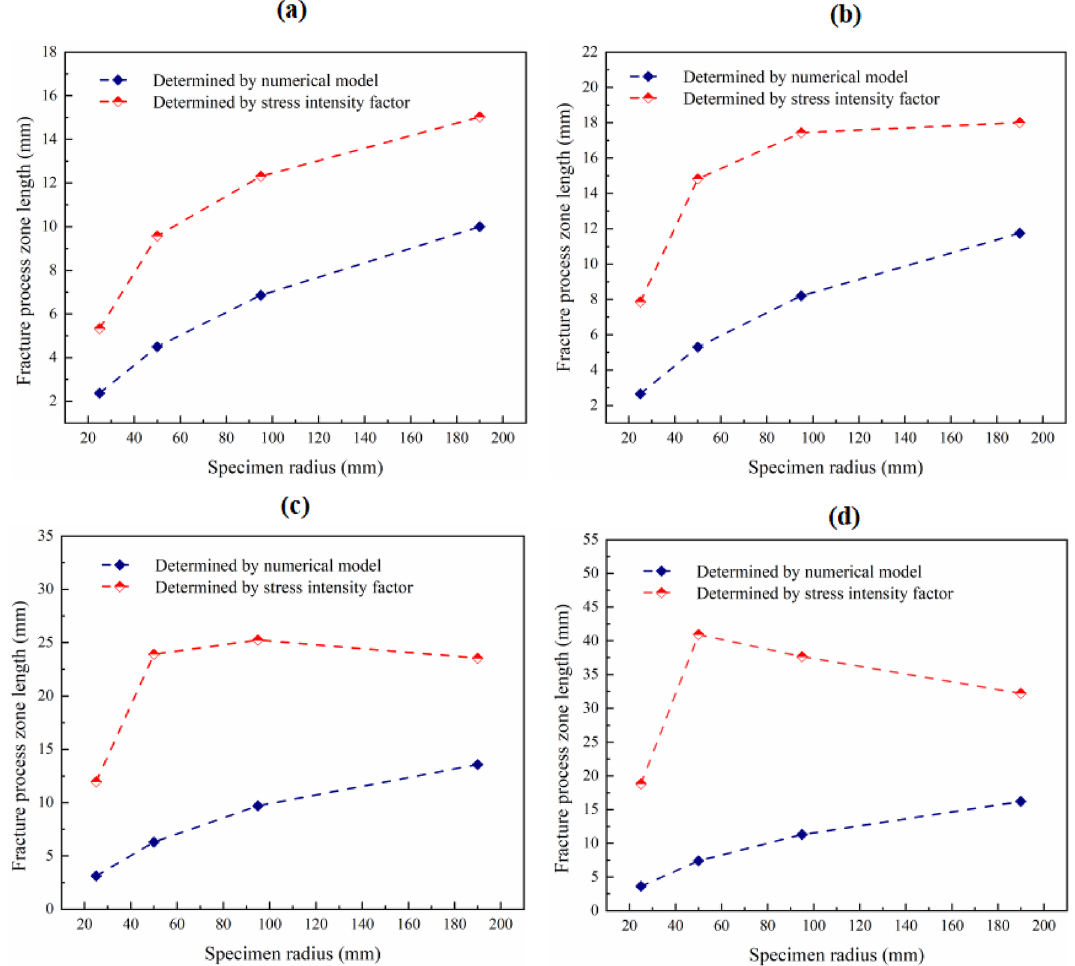
Figure 11. Variation of the fracture process zone length with specimen size under different friction coefficients. Where ( a ) is friction coefficient of 0; ( b ) is friction coefficient of 0.1; ( c ) is friction coefficient of 0.2; and ( d ) is friction coefficient of